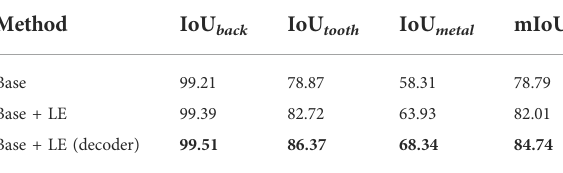
Bold values indicates the best performing parameter.